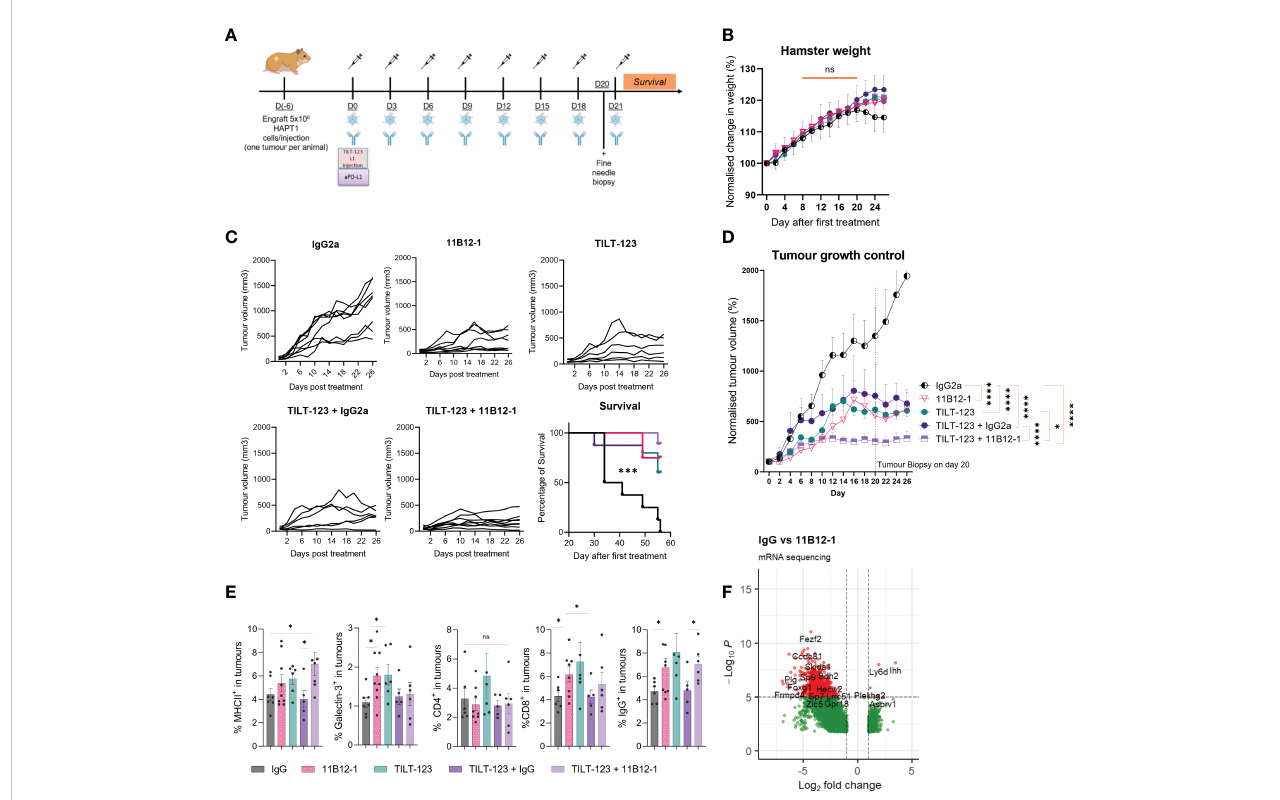
FIGURE 5 Combination therapy with 11B12-1 and oncolyticadenovirus Ad5/3-E2F-D24-hTNF a -IRES-hIL-2provides superior tumour growth controlin a Syrian hamster model ofpancreatic ductal adenocarcinoma. (A) Schematic oftreatment scheme. HapT1 (heterotopic PDAC) bearingSyrianhamsters(n=8pergroup) were intraperitoneally injected with 11B12-1(300 µg) orisotype control (300 µg) and with or without intratumoural injection of1x10 8 VPs of Ad5/3-E2F-D24-hTNF a - IRES-hIL-2. Treatments weregiven every three days for a total of 8 treatments. Fine needle tumourbiopsies weretaken onthe day beforethe last treatment for evaluation ofmechanismof action. (B) Percentage change in weight of hamstersafter treatments. Data is normalized to day 0. (C) Individual tumour growth curveswith 60 day survival analysis. (D) Mean percentagechangein tumour volume over28days. (E) Phenotypic analysis ofintratumoural immune cells in fi ne needleaspirates by fl ow cytometry. (F) Volcano plot for signi fi cantlydifferentially expressed genes between IgG2a and anti-PD-L1 clone 11B12-1. DESeq2 was used tocomparegene expression betweengroups and the Wald test was used togenerate p-values and log2 fold changes. Genes with an adjusted p-value < 0.05 and absolute log2fold change > 1 weredeterminedas differentially expressed genes. Signi fi cance for tumour growth controls was calculatedusingtwo- way mixed modelANOVA and survival curves by Mantel – Cox log-ranktest.Statistical signi fi cance of fl ow cytometrydata was evaluated usinganunpaired t-test with Welch ’ s correction. *p< 0.05,***p< 0.001, ****p < 0.0001 ns notsigni fi cant. All data and error barsare presented as mean ±